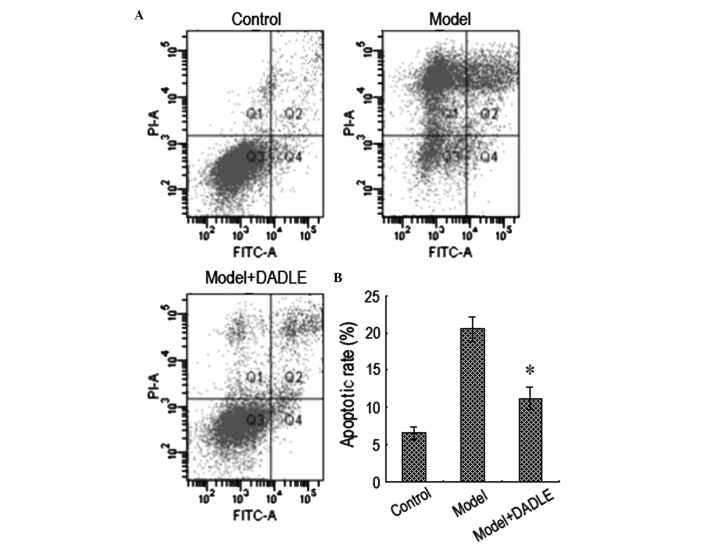
DADLE inhibits ischemia/reperfusion-induced intestinal epithelial cell apoptosis. (A) Detection of intestinal epithelial cell apoptosis using annexin V/PI double staining. (B) Histogram of the percentages of apoptosis in the intestinal epithelial cells. *P<0.01, compared with the model group. Each independent experimental group was repeated in triplicate. Data are presented as the mean ± standard deviation. DADLE, (D-Ala2, D-Leu5)-enkephalin; PI, propidium iodide; FITC, fluorescein isothiocyanate; Model, ischemia/reperfusion.